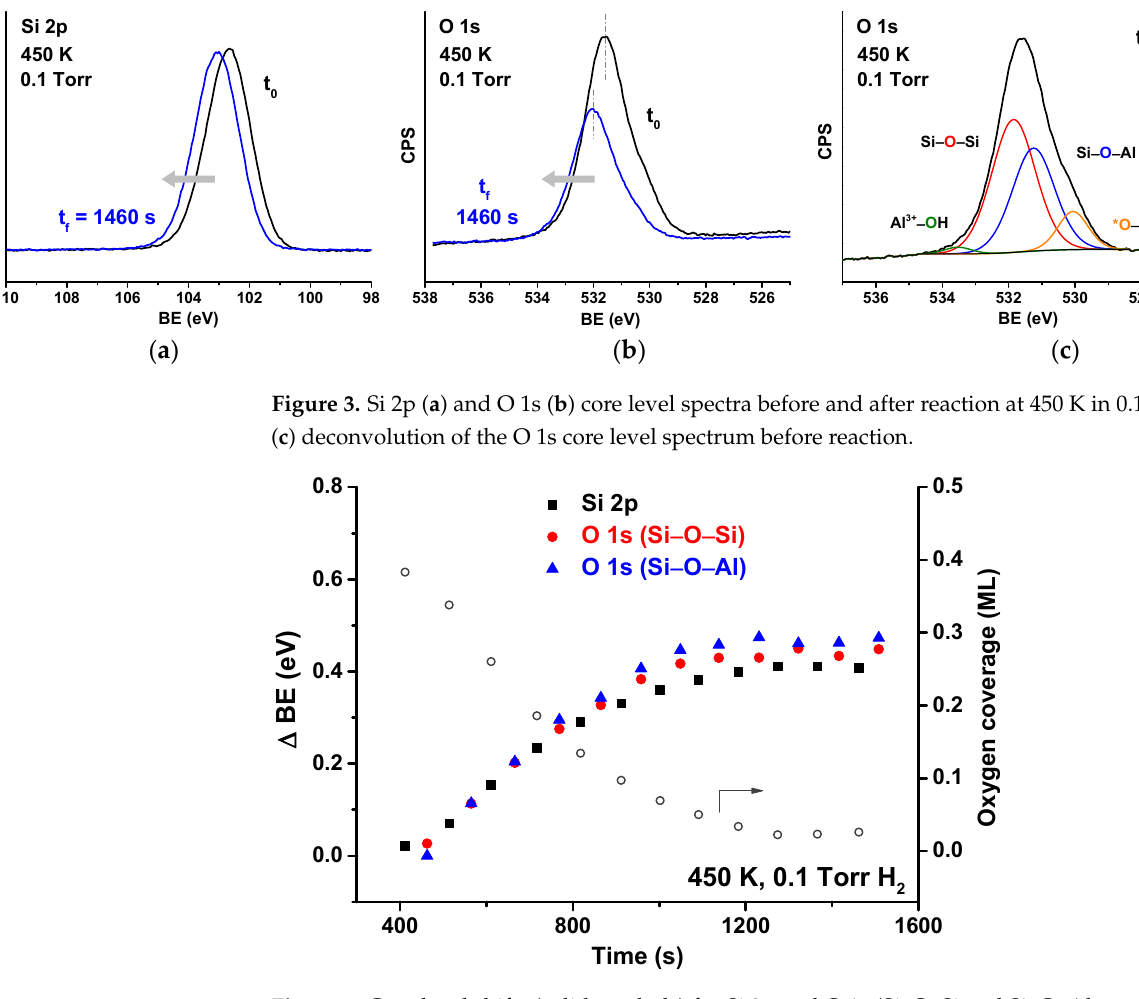
Figure 4. Core level shifts (solid symbols) for Si 2p and O 1s (Si–O–Si and Si–O–Al components) as a function of time at 450 K in 0.1 Torr of H 2 . The coverage of chemisorbed O (open circles) is also shown for comparison.